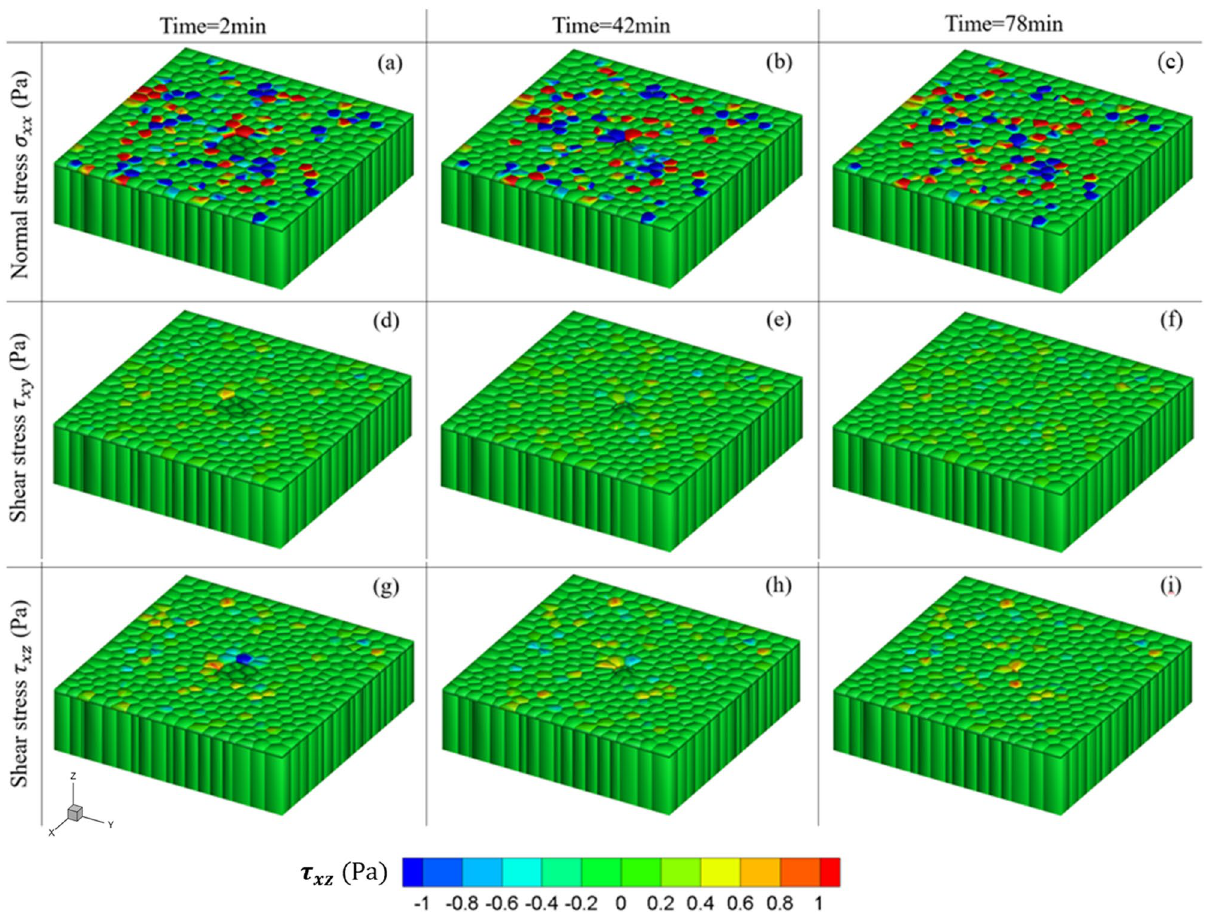
Figure 4. Snapshots of comparing the normal stress distribution with the shear stress distribution during the wound closure process: ( a – c ) show the normal stress σ xx at different timestep; ( d – f ) show the shear stress τ xy at different timestep; ( g – i ) show the shear stress τ xz at different